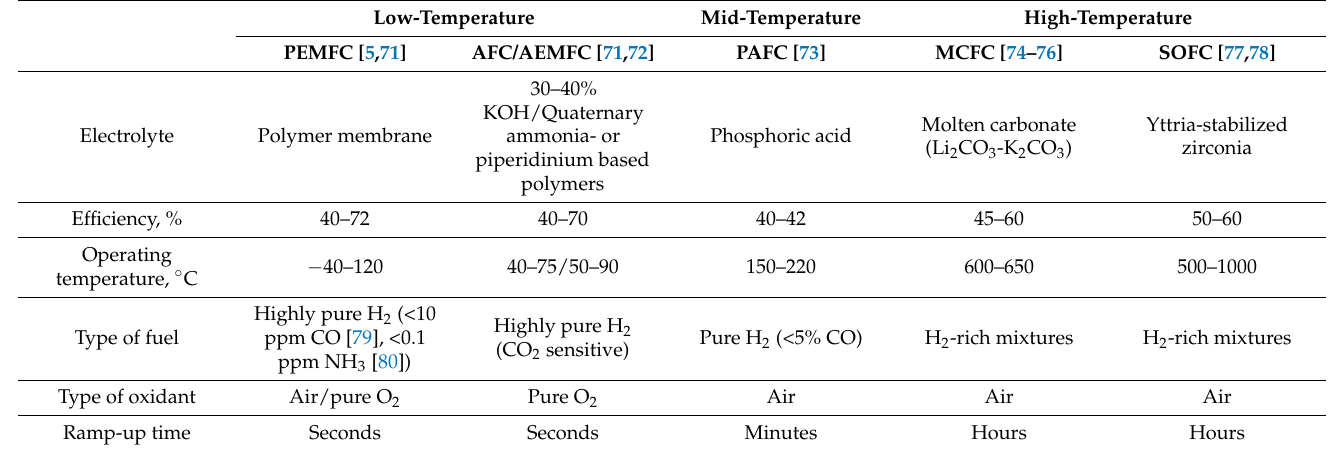
Table 5. Characteristics of different types of hydrogen